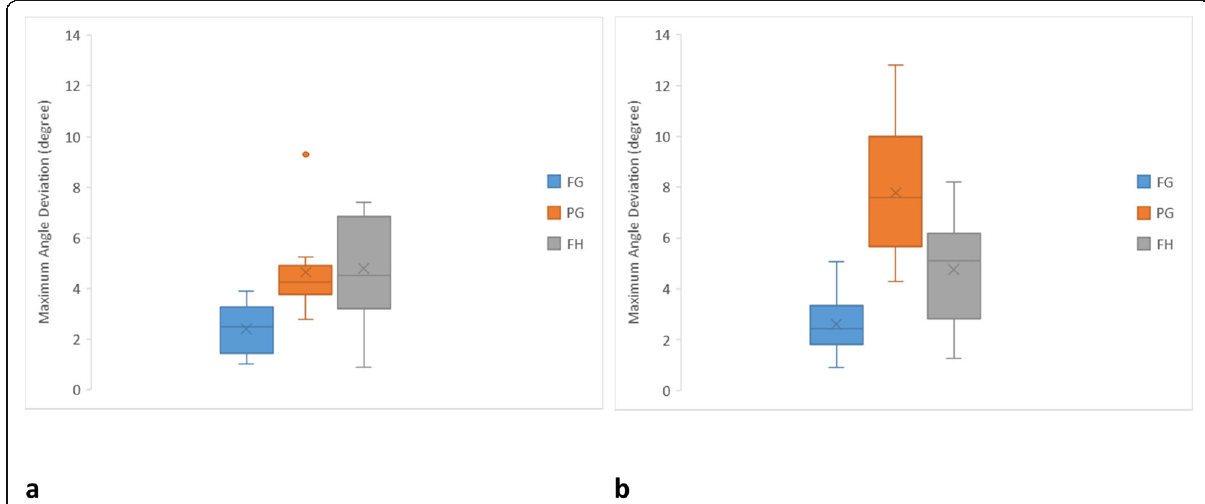
Fig. 8 Box plot diagrams illustrating the distribution of maximum angle deviation of each protocol. a Anterior implants. b Posterior